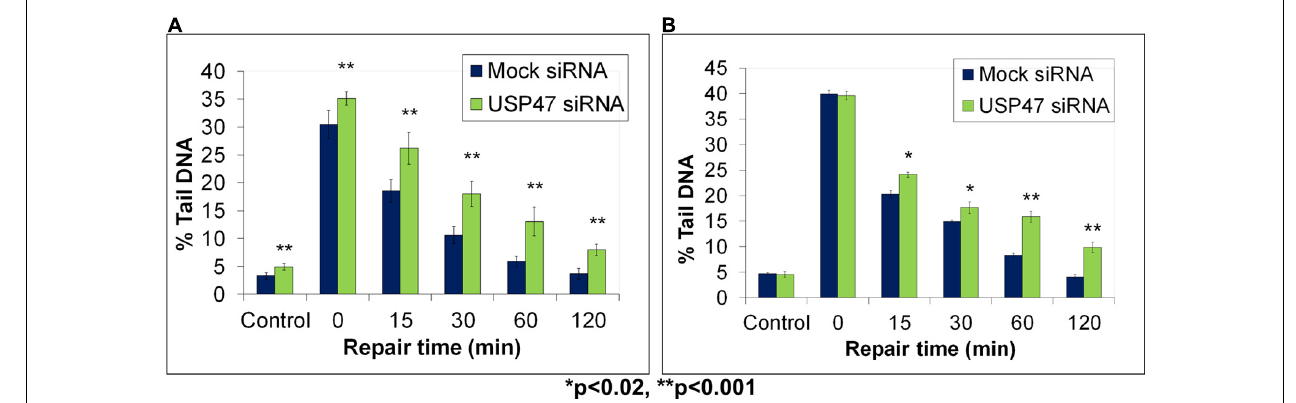
DNA damage repair. Mean % tail DNA values with SDs were calculated. Further details are provided in Figure 4 legend. Statistically significant results comparing Lipofectamine and siRNA-treated cells are represented by * p < 0.02 and ** p < 0.001, as analyzed by Student’s t -test. Panel (A) taken and modified from Parsons etal. (2011) and Panel (B) represents unpublished